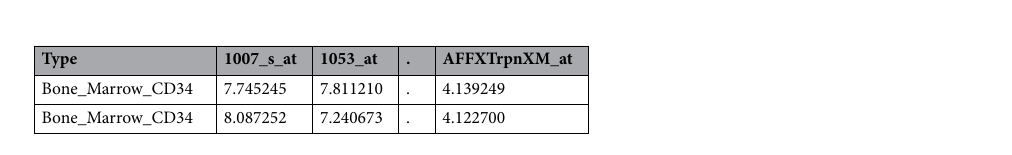
Table 8. Sample of Leukemia_GSE9476